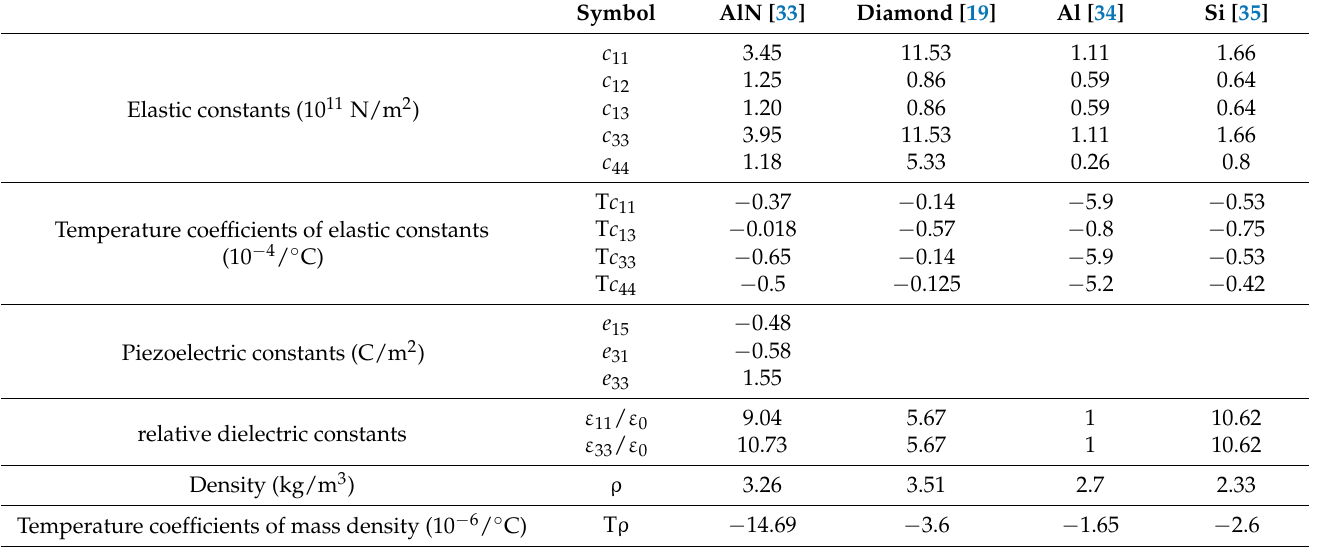
Table 3. Material